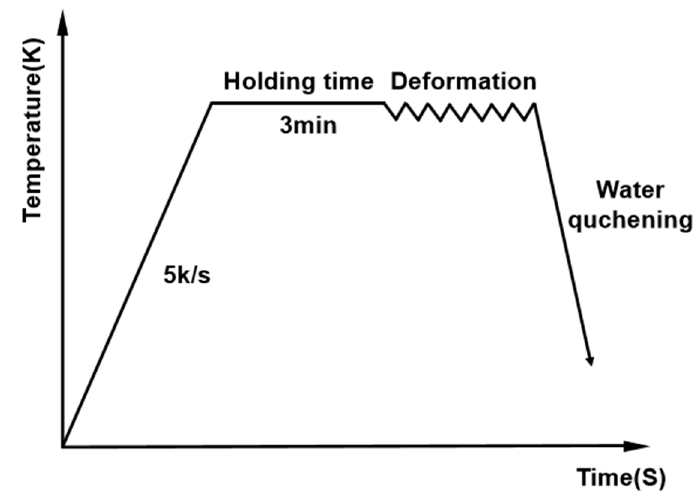
Figure 1. Process flowchart of the isothermal compression process.